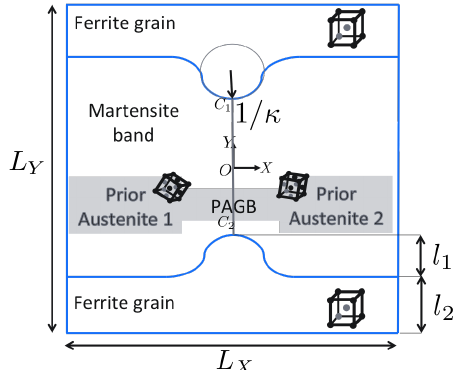
Figure 3. Schematic of the microstructure volume element used in the simulations. It consists of ferrite region of single orientation. The martensite band region transforms from the two prior austenites. The aspect ratio of L X / L Y = 1 is considered. The origin is at the center and the values of l 1 = 0.15 L Y and l 2 = 0.1 L Y are considered.